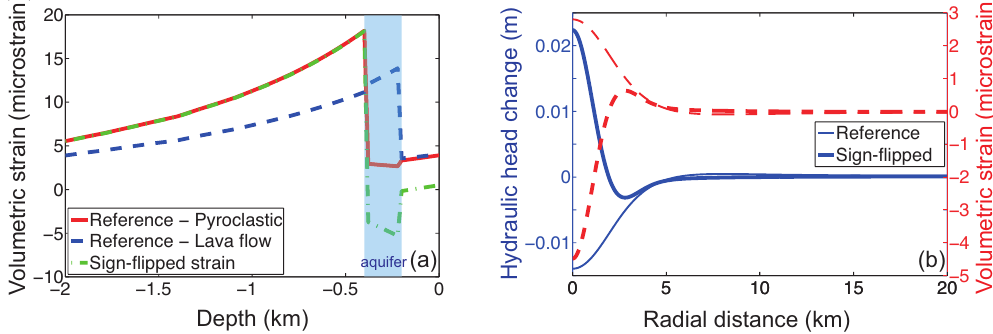
Figure 7. (a) shows vertical strain profiles through the centre of the domain from 2km depth to the surface, for different elastic stratigra- phies: the two reference simulations and a setting in which the sign of strain (and consequently hydraulic head) is flipped from dilation to compression due to a sufficiently stiff cap rock (ER c = 1000). (b) shows hydraulic head change and volumetric strain along a horizontal profile through the aquifer in the reference pyroclastic aquifer in comparison to the aquifer, where sign of strain and head is flipped.